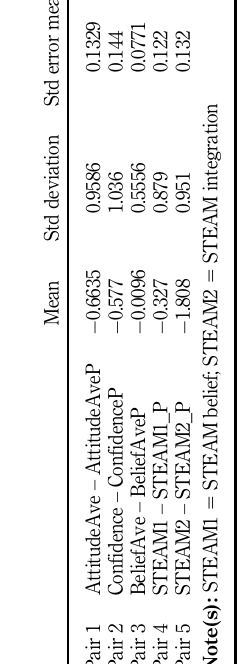
Table 1. Paired samples test